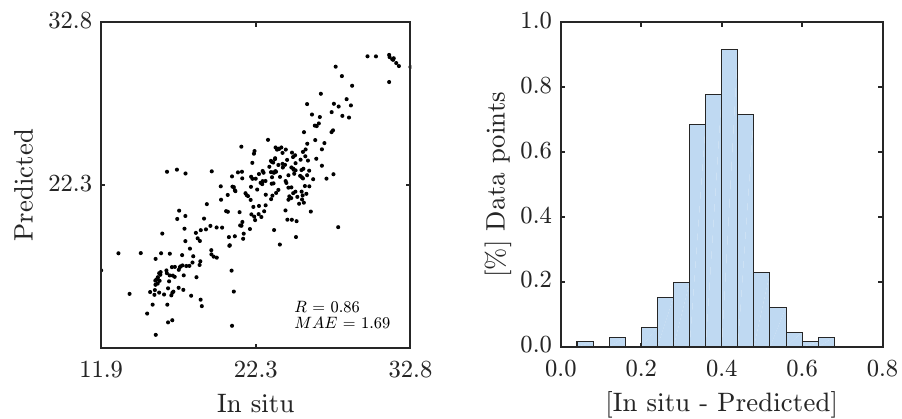
Figure 10. Temperature extrapolation. Test : predicted and in situ data time series ( top ); predicted vs. in situ data ( bottom left ); histogram of residuals ( bottom right ). Units of temperature are ◦ C.